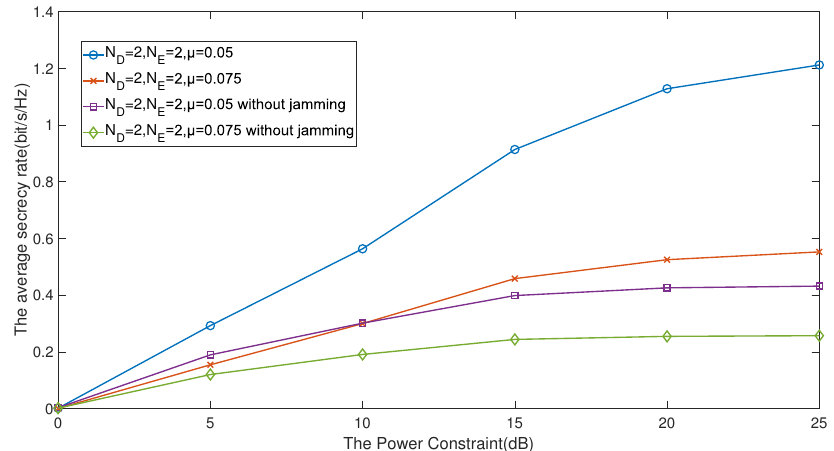
Figure 4. Average secrecy rate versus power constraint comparison of different